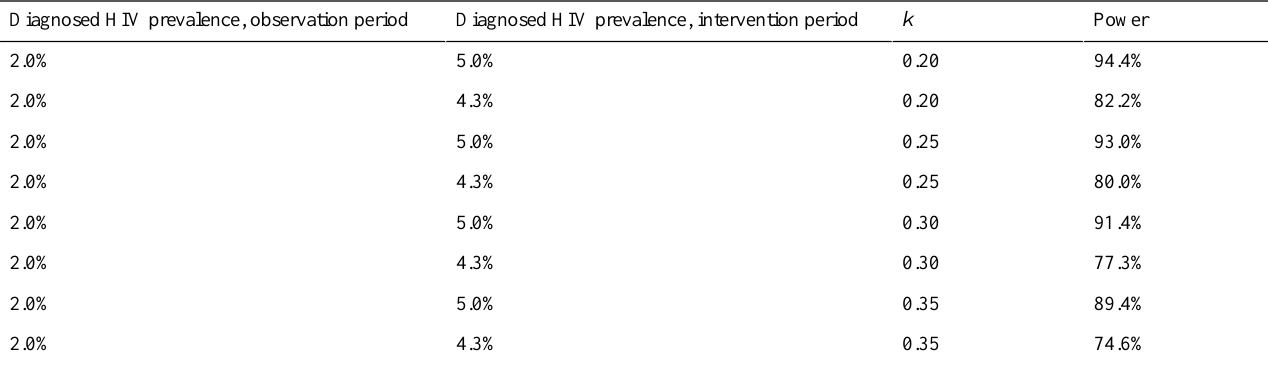
Table 1. Power for evaluation of null hypothesis that HIV diagnosis rates are equal.